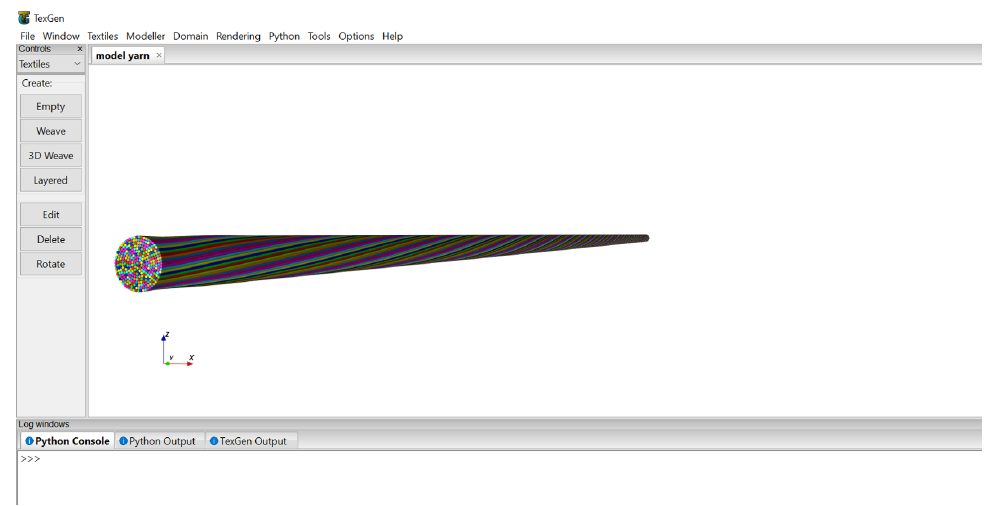
Figure 13. Yarn model in TexGen.